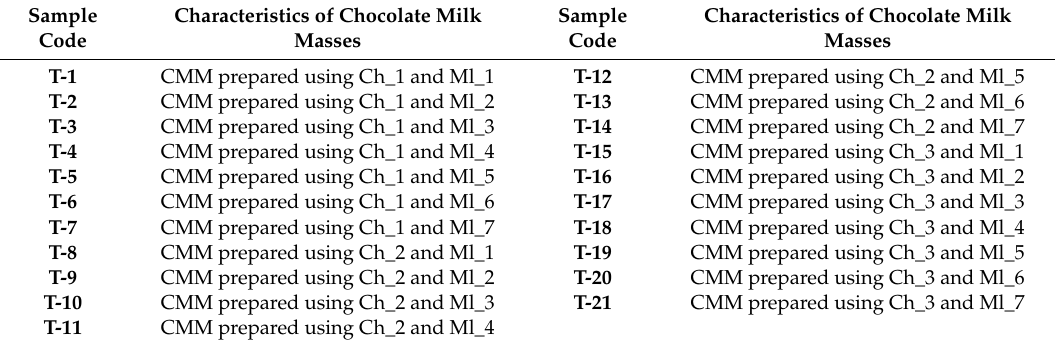
Table 3. List and marking of chocolate milk